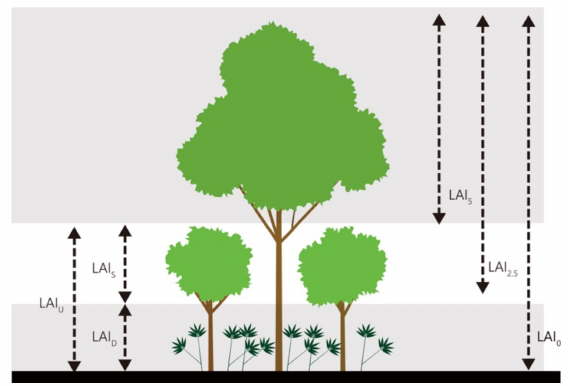
Figure 3. The design of leaf area index (LAI) measurement. Understory-layer (LAI U ); Dwarf bamboo-layer (LAI D ); Shrub-layer (LAI S ); LAI measured at 5 m above the ground (LAI 5 ); LAI measured at 2.5 m above the ground (LAI 2.5 ); LAI measured at 0 m above the ground (LAI 0